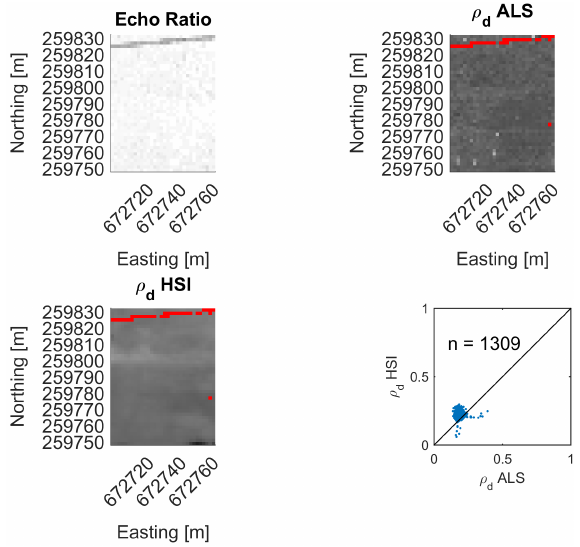
Figure 5: Results for test area 1, evaluated for a minimum echo ratio of 75% . Reflectance values are shown in grayscale from 0 (black) to 1 (white) and the echo ratio is visualized analogously. Pixels excluded from the analysis due to an echo ratio below the threshold are shown in red.